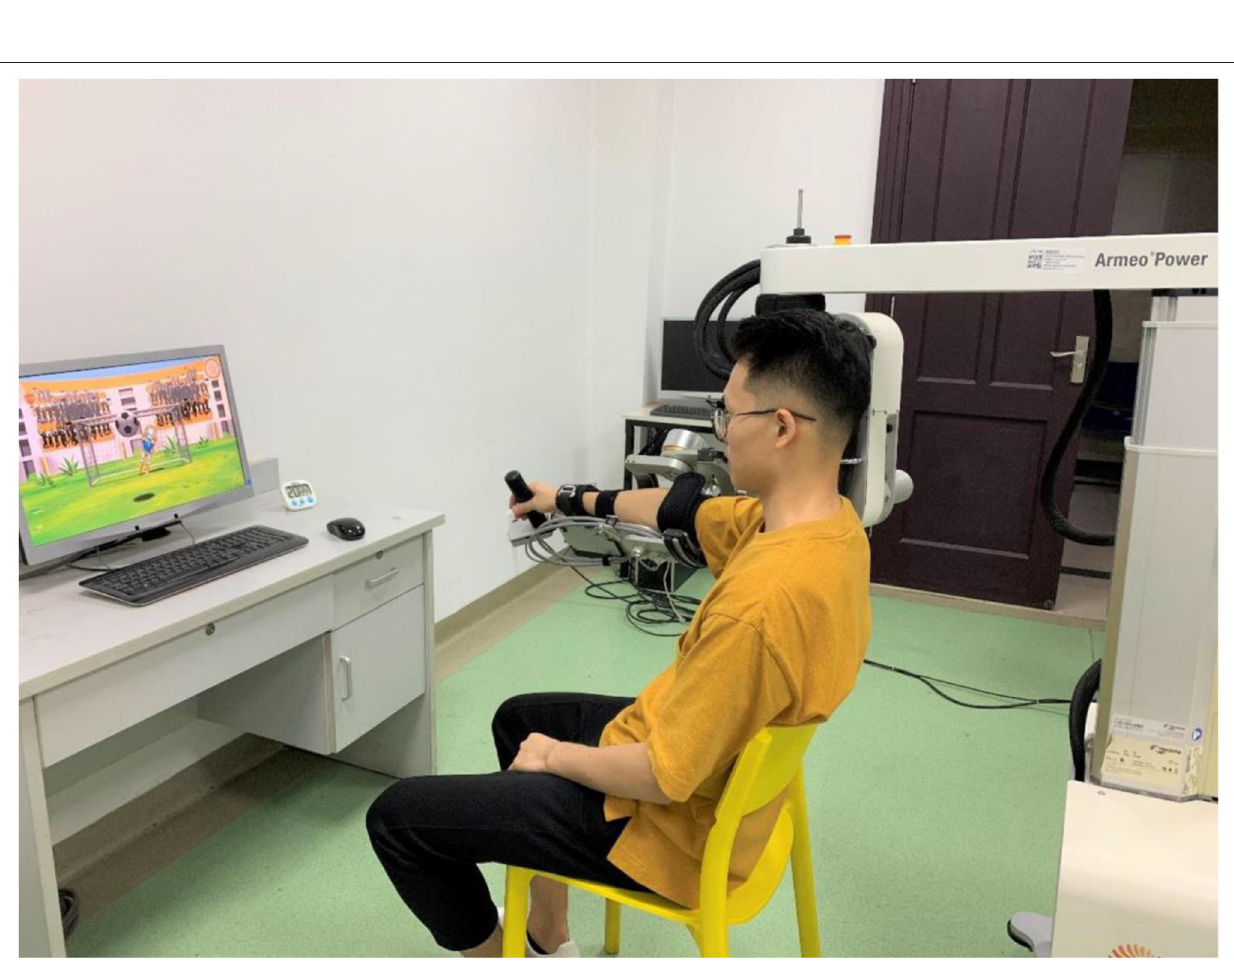
Frontiers in Neurology |